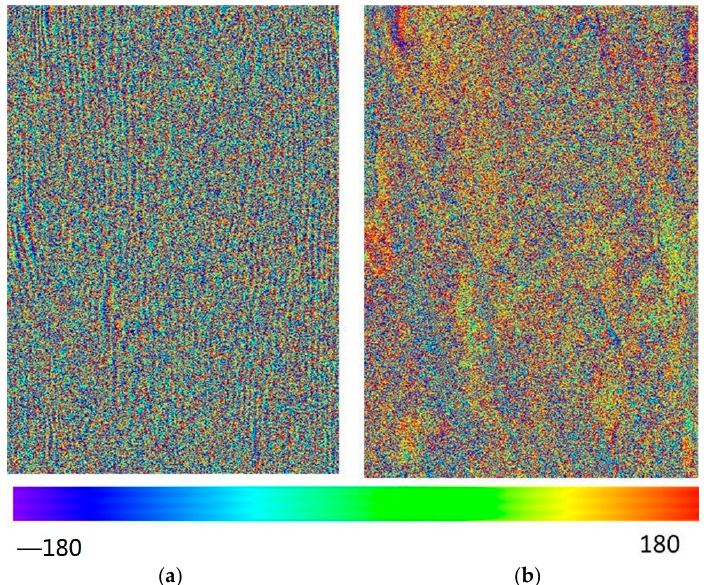
Figure 4. The interferometric phase diagram of the 73–75 image pair in HV (Horizontal-Vertical) polarization. ( a ) Before removal of terrain phase; ( b ) After removal of terrain phase